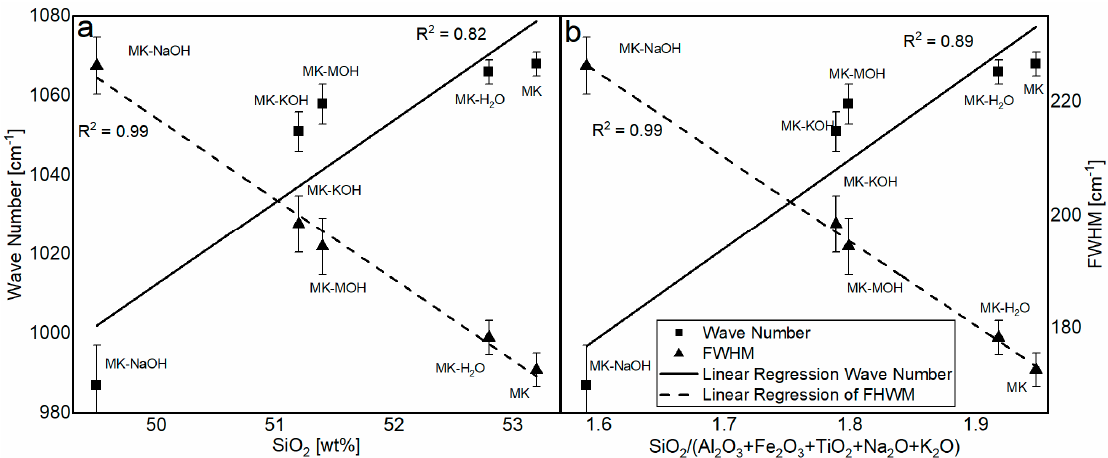
Figure 8. Correlation of the SiO 2 content ( a ) and the molar ratio of SiO 2 / (Al 2 O 3 + Fe 2 O 3 + TiO 2 + Na 2 O + K 2 O) ( b ) in the aluminosilicate structure with the wavenumber and FWHM.